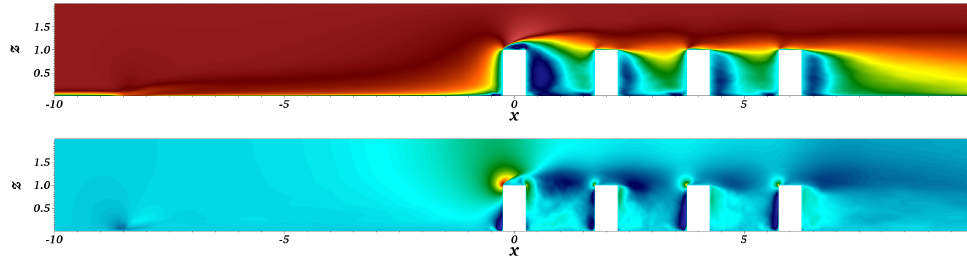
Figure 3. ( Top ) Mean streamwise velocity U , where colors range from (dark blue) − 0.4 to (dark red) 1.1. ( Bottom ) Mean wall-normal velocity W , with colors ranging from (dark blue) − 0.35 to (dark red) 1. The y = 0 plane is